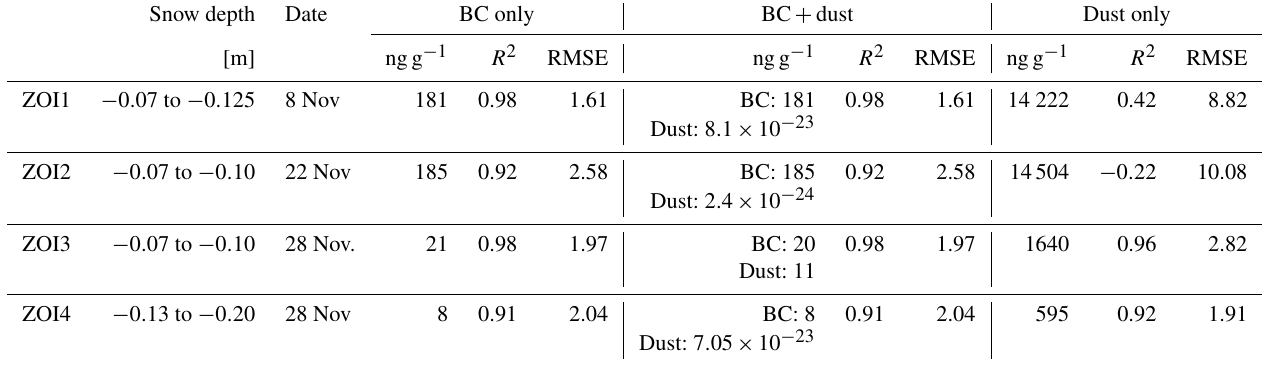
Table 2. Fit between measured and calculated extinction coefficient curves ( k e (λ) ) for measurements in shrub-free snowpacks. Calculated k e (λ) was computed with black carbon (BC), BC and mineral dust, or mineral dust only. The fit between measured and calculated k e (λ) was analyzed with the coefficient of determination ( R 2 ); the error is indicated with the root-mean-square error (RMSE). Snow depth Date BC only BC + dust Dust only [m] ngg − 1 R 2 RMSE ngg − 1 R 2 RMSE ngg − 1 R 2 RMSE ZOI1 − 0 . 07 to − 0 . 125 8 Nov 181 0.98 1.61 BC: 181 0.98 1.61 14 222 0.42 8.82 Dust: 8 . 1 × 10 − 23 ZOI2 − 0 . 07 to − 0 . 10 22 Nov 185 0.92 10.08 Dust: 2 . 4 × 10 − 24 ZOI3 − 0 . 07 to − 0 . 10 28 Nov. 21 0.98 1.97 BC: 20 1640 Dust: 11 ZOI4 − 0 . 13 to − 0 . 20 28 Nov Dust: 7 . 05 × 10 −